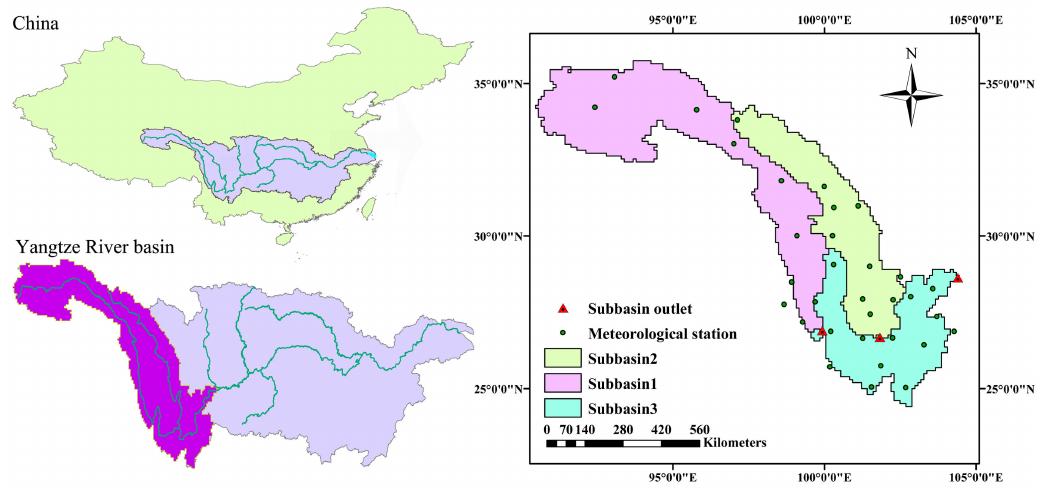
Figure 3. The Jinshajiang River basin, China